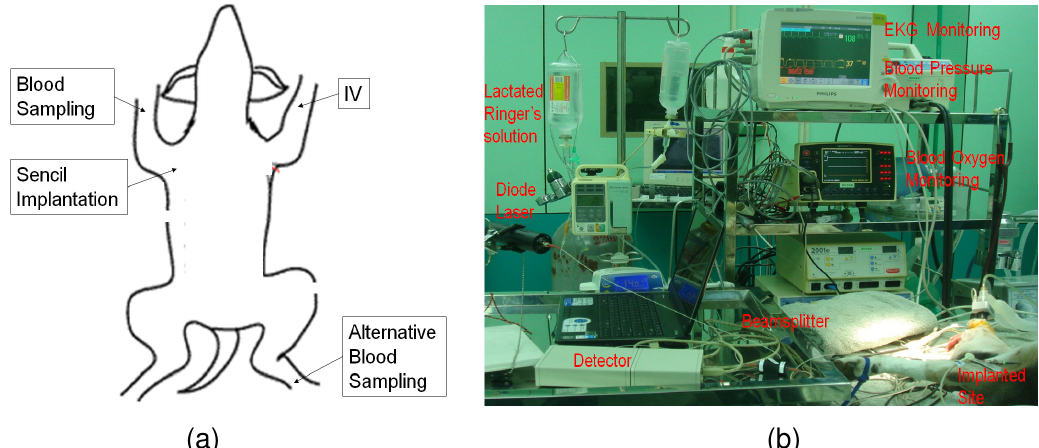
Figure 2. Illustration of the relative spacial positions for implantation, blood sampling and IV infusion on each subject (a). Arrangement of devices around the operation table